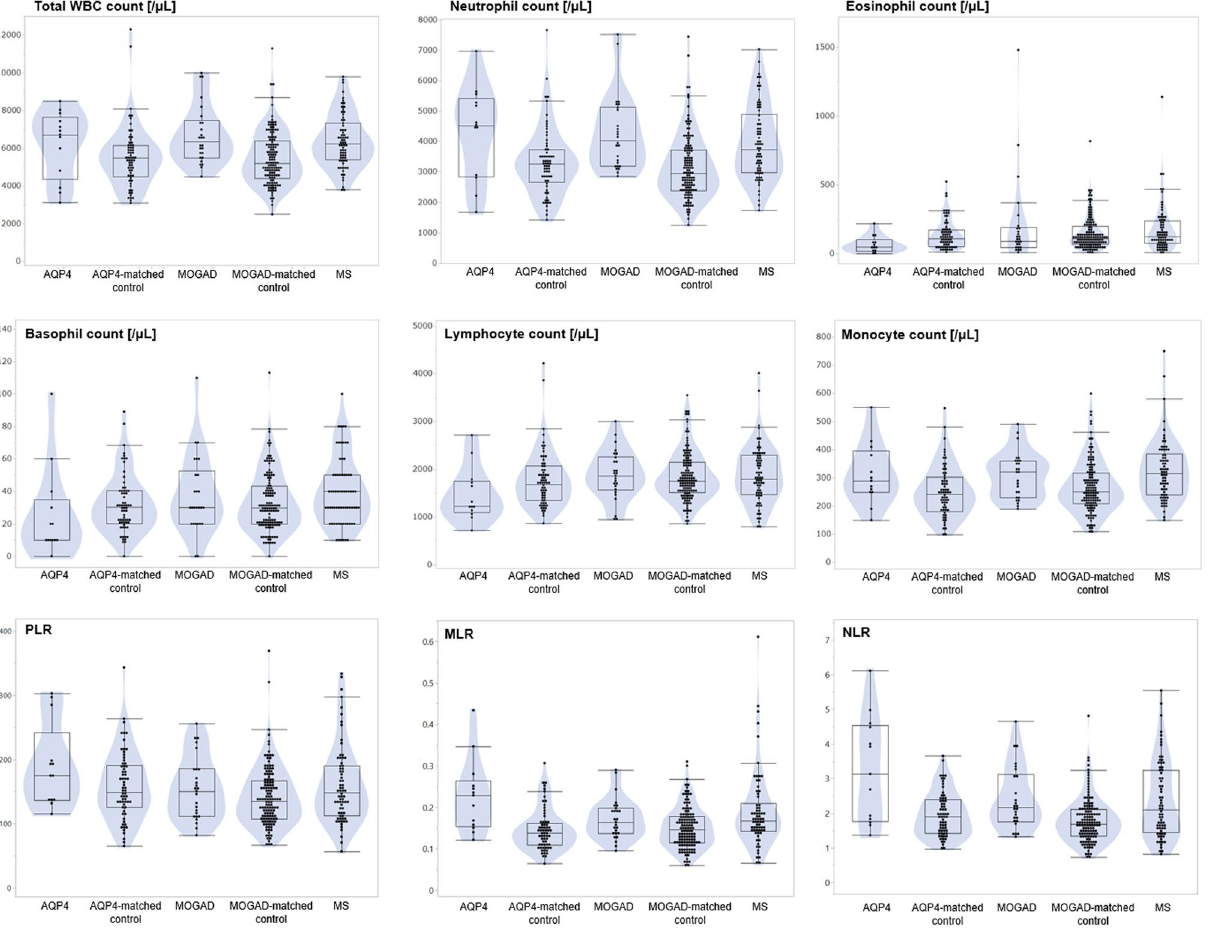
Figure 1. Distributions of the total and differential WBC counts in each group. Violin plots and box-whisker plots for the total and differential WBC counts, PLR, MLR, and NLR in each of the five groups are shown. The distributions of total WBC count, neutrophil count, monocyte count, MLR, and NLR were higher in patients with AQP4-IgG-positive NMOSD and MOGAD than in their matched volunteers as control